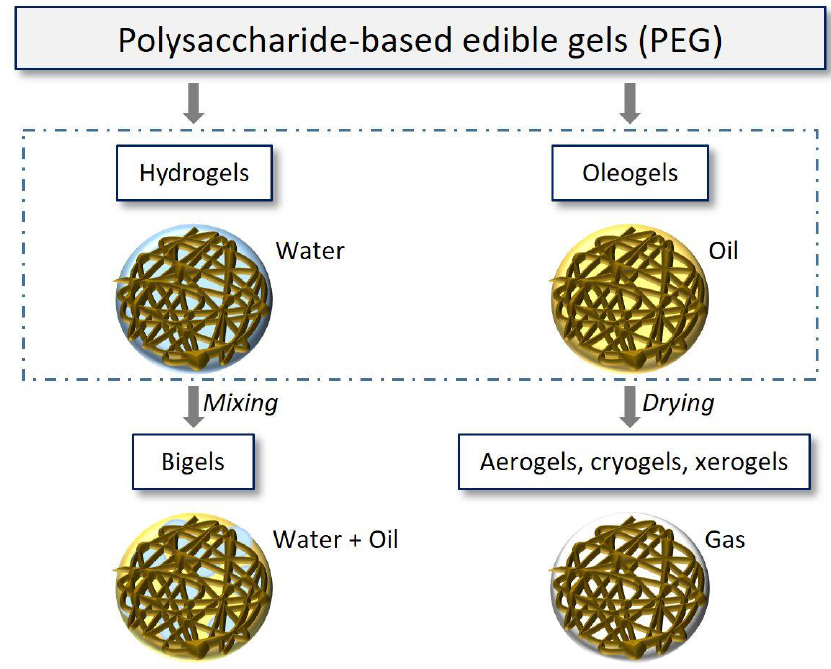
Figure 1. Classification, structure, and formulation of polysaccharide-based edible gels.